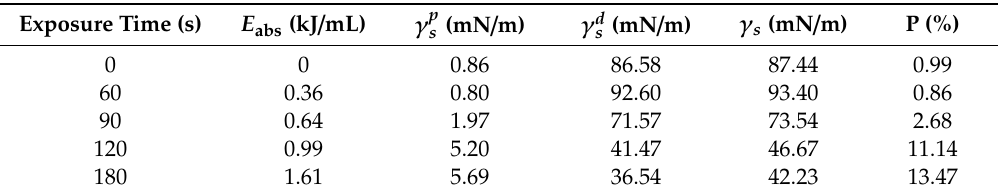
Table 4. The surface tension components of PVA foils obtained before and after exposure of solutions to MW radiation, for di ff erent absorbed